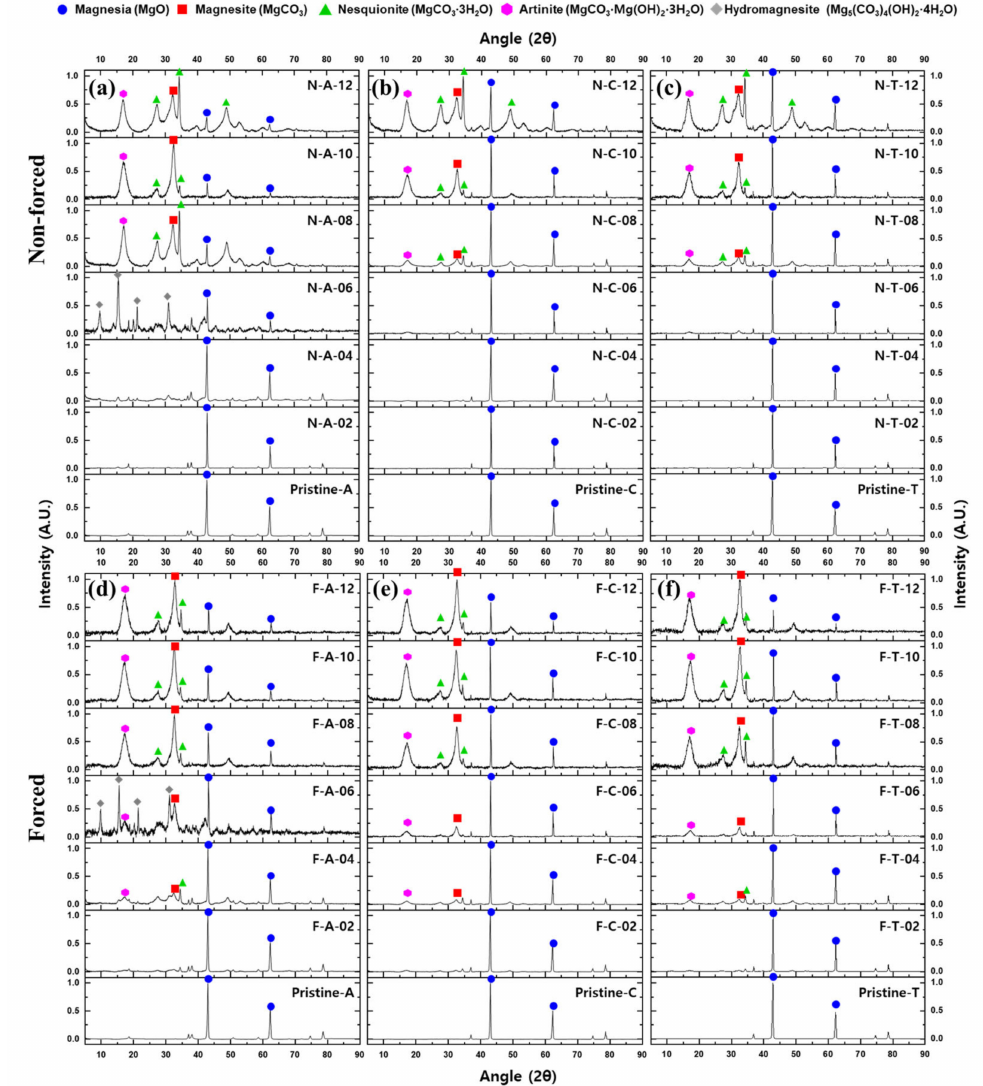
Figure 1. XRD results of the samples for the non-forced (N) wet carbonations of ( a ) A-MgO, ( b ) C- MgO and ( c ) T-MgO as well as forced (F) wet carbonations of ( d ) A-MgO, ( e ) C-MgO and ( f )